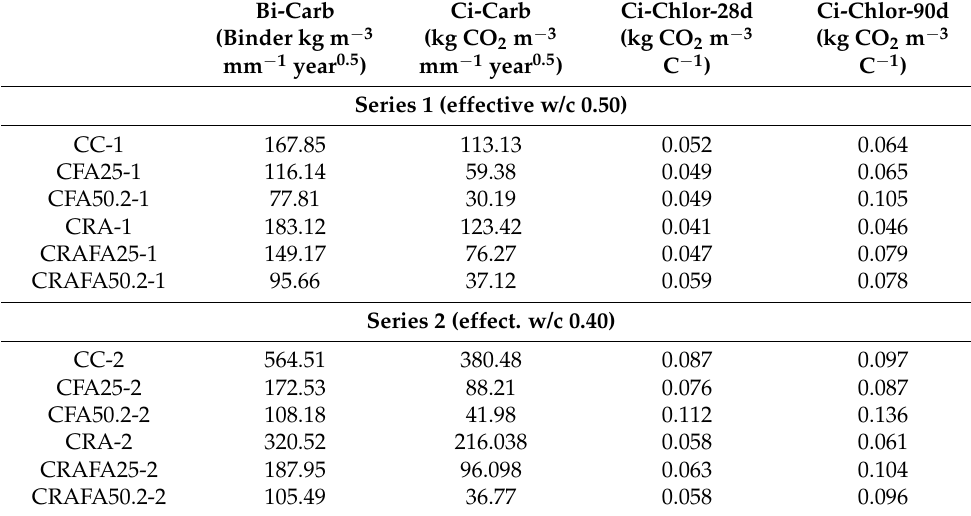
( b ) Figure 13. The Bi-comp versus Ci-comp relation for ( a ) Series 1 and ( b ) Series 2.